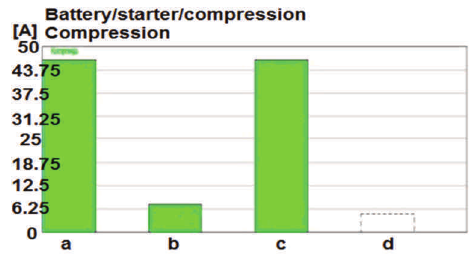
Fig. 13. Relative compression for two spark